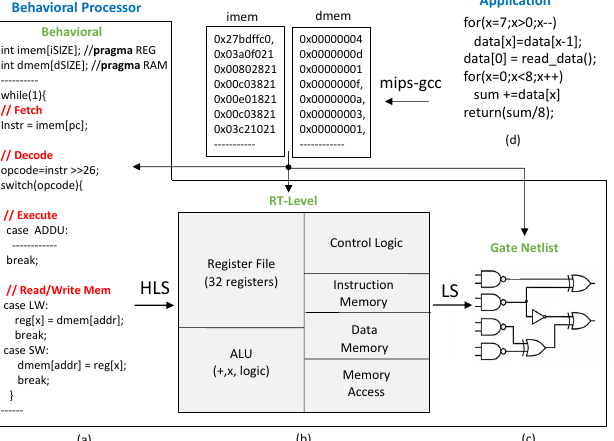
Figure 5. Simple behavioral MIPS scalar processor. ( a ) Behavioral description of the processor.